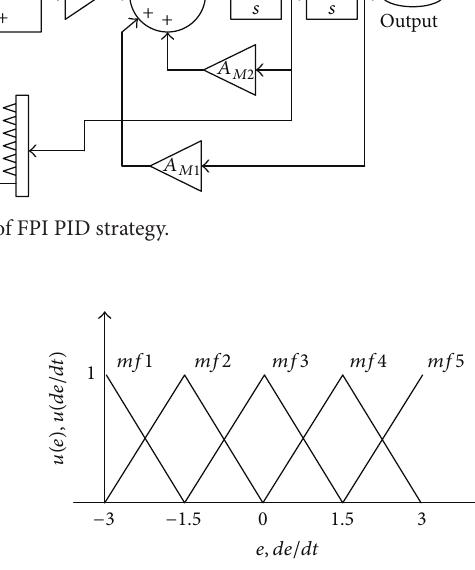
Figure 7: Membership function plots for both function sequences.